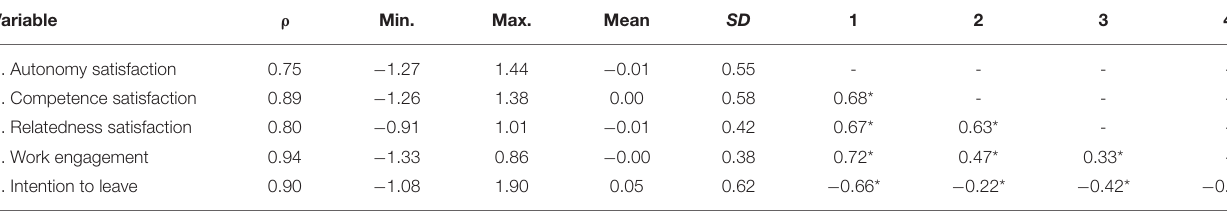
TABLE 2 | Descriptive statistics, reliabilities, and Pearson correlations of the distal variables. Variable ρ